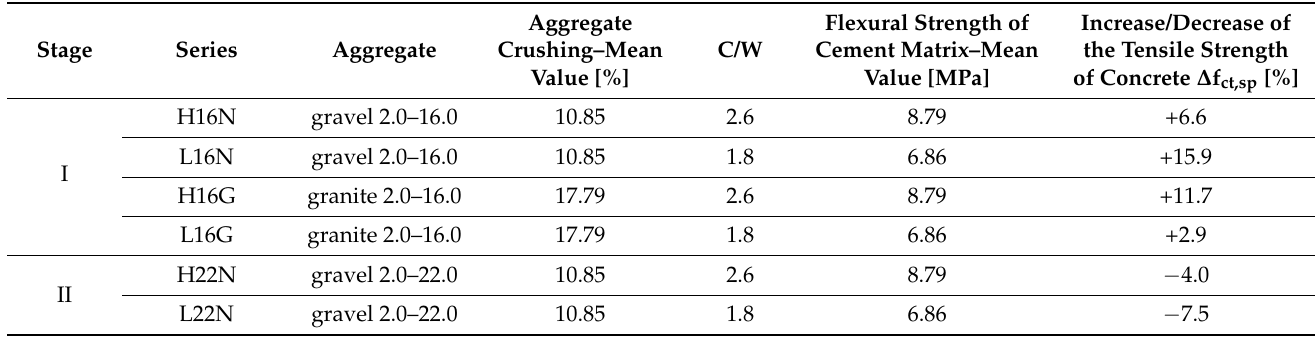
Table 5. Increase/decrease of the tensile splitting strength of concrete and strength properties